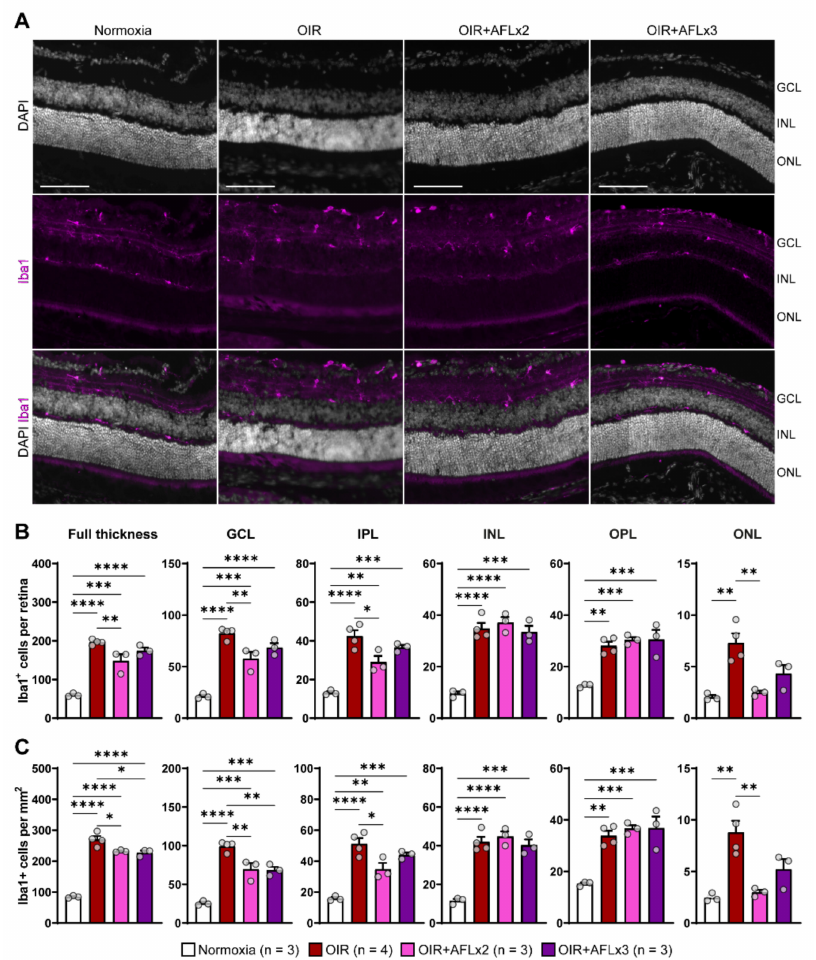
Figure 2. Immunofluorescent labeling and quantification of Iba1 + cells in retinal cross sections. ( A ) Representative micrographs of Iba1 (magenta) immuno-fluorescently labeled retinal cross-sections from P19 Normoxic, OIR, OIR+AFLx2, and OIR+AFLx3 mice. DAPI counterstain is shown in greyscale. GCL, ganglion cell layer; INL, inner nuclear layer; ONL, outer nuclear layer. Scale